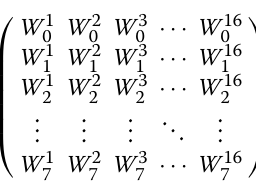
as Fig. 1 to an ( 8 × 16 ) -sized matrix: